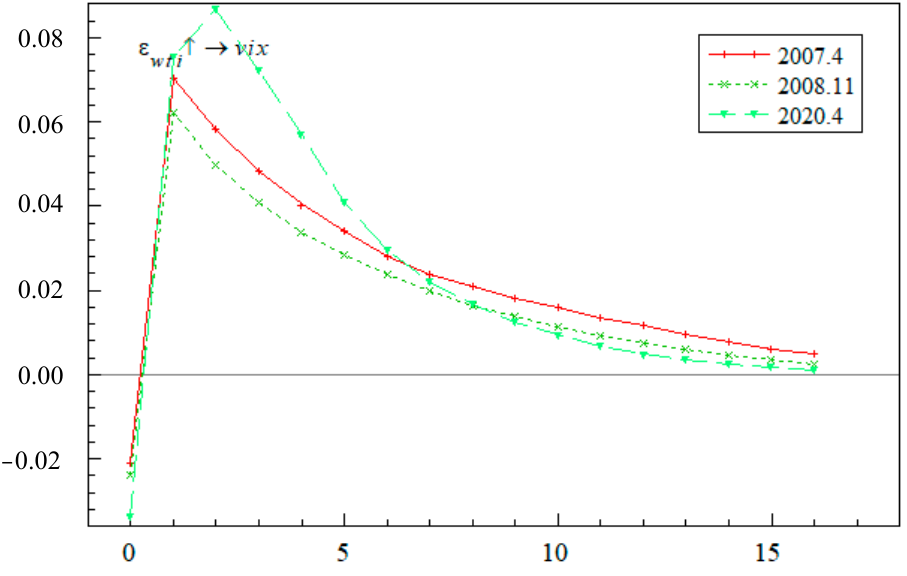
Figure 4. Impulse response of VIX index to crude oil price at different time points.